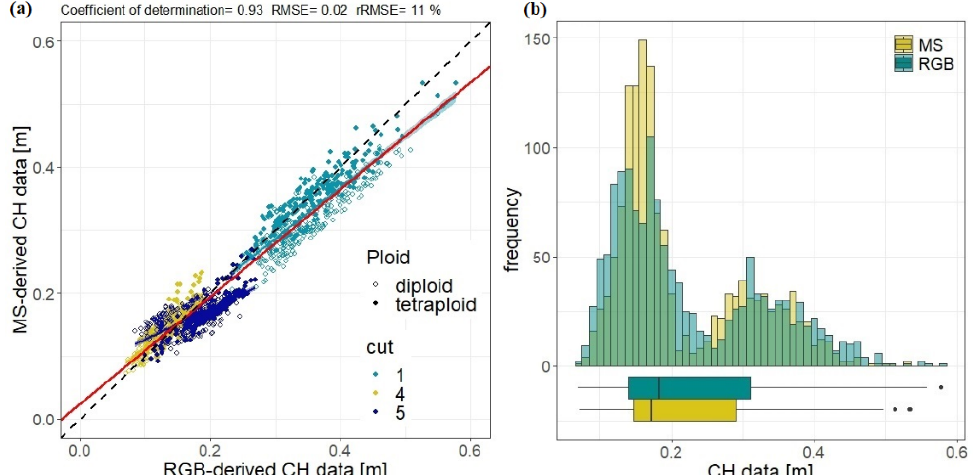
Figure 4. Comparison of the UAV-derived Canopy Height Model (CHM) based on two sensors; ( a ) linear regression of mean CHM between two paired datasets derived from the multispectral (MS) vs. RGB camera systems. A regression line was fitted separately for each cut and for the whole dataset (red solid line); ( b ) distribution of mean canopy height information derived from multispectral and RGB camera visualized on histograms and box plots.